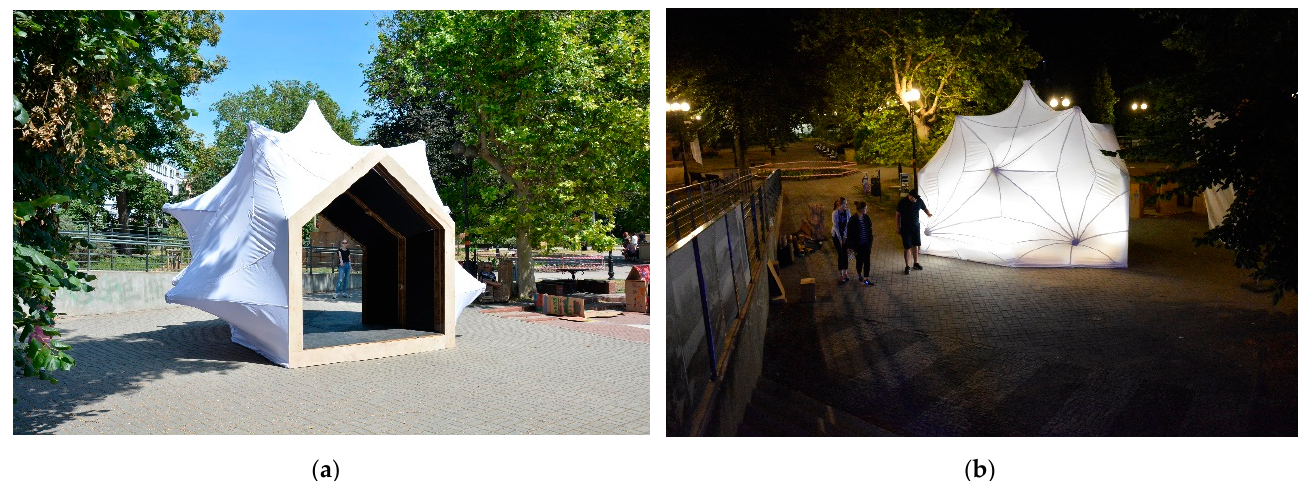
Figure 18. The Obverse/Reverse Pavilion: ( a ) pavilion in daylight; ( b ) pavilion at night.